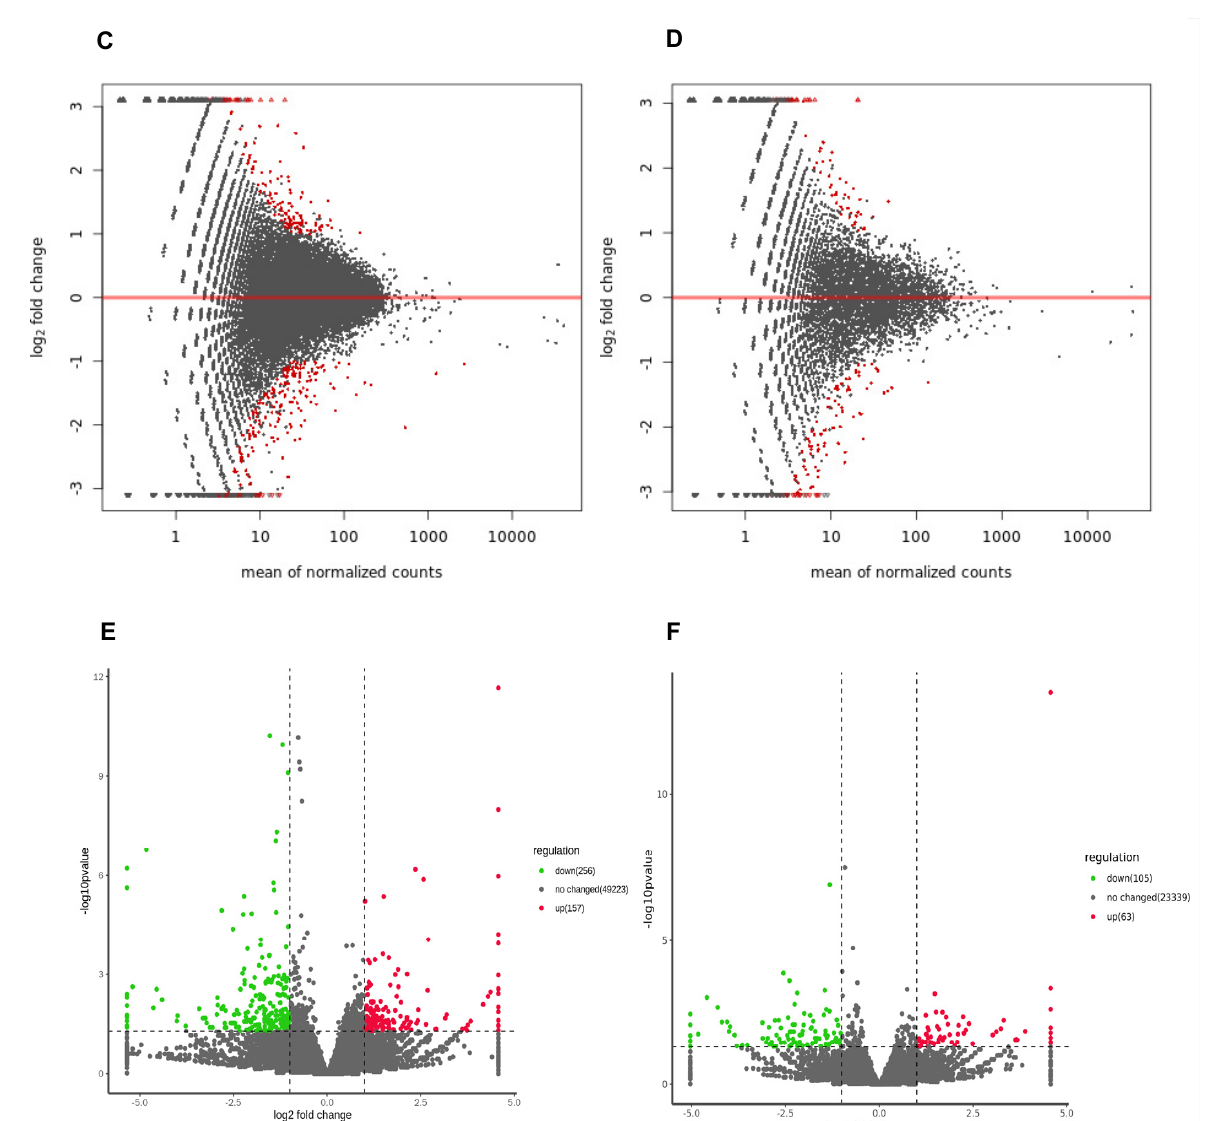
Figure 6. Differential methylation in CG and CWG sites between EG-vs.-CK. ( A ) The number of differentially methylated CG and CWG sites. ( B ) the number of hypo/hypermethylated CG and CWG sites. ( C , D ) MA plot of DMS in CG and CWG sites. ( E , F ) Volcano plot of the DMS in CG and CWG sites. The small red circle represents upregulated DMS. The blue and dark grey color means the downregulated DMS and non-significant methylated